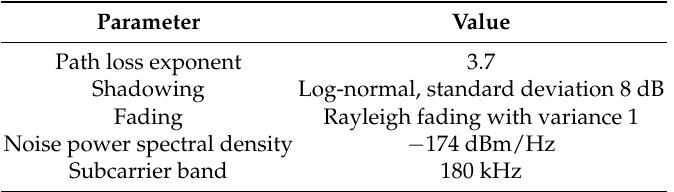
Table 2. Simulation Parameters.